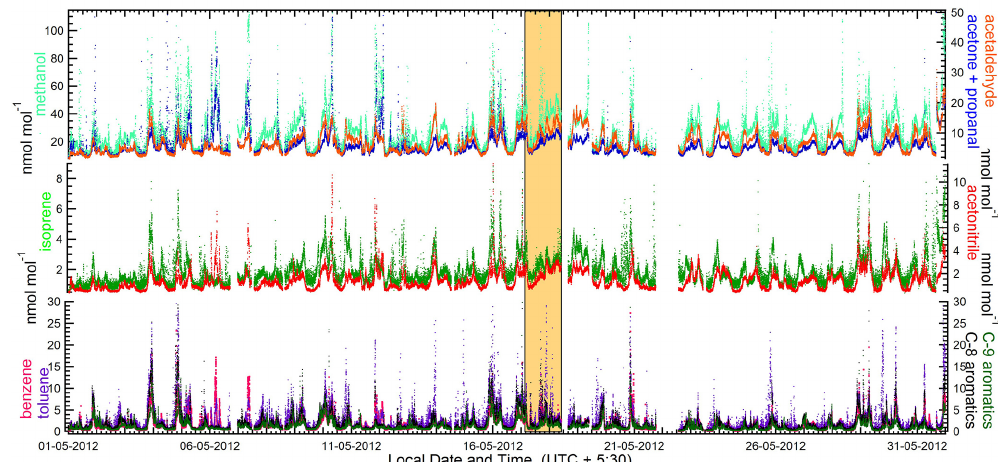
Figure 6. Time series of the one-minute data in May 2012 for the mixing ratios of methanol, acetaldehyde, the sum of acetone and propanal (top panel), isoprene and acetonitrile (middle panel) and benzene, toluene, the sum of C8-aromatics (xylene isomers and ethyl benzene), and the sum of C9-aromatics (isomers of trimethyl benzenes and propyl benzenes) (bottom panel).